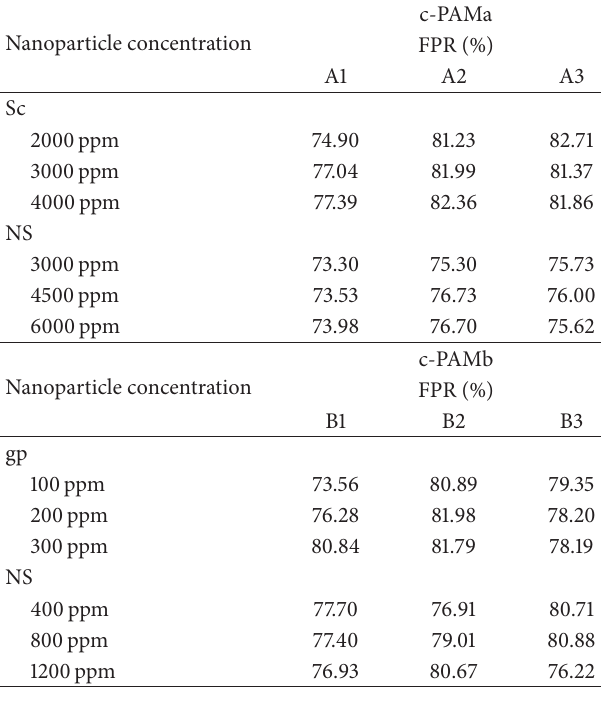
Table 2: The first pass retention rates of pulp stock with NS substituting Sc and gp.